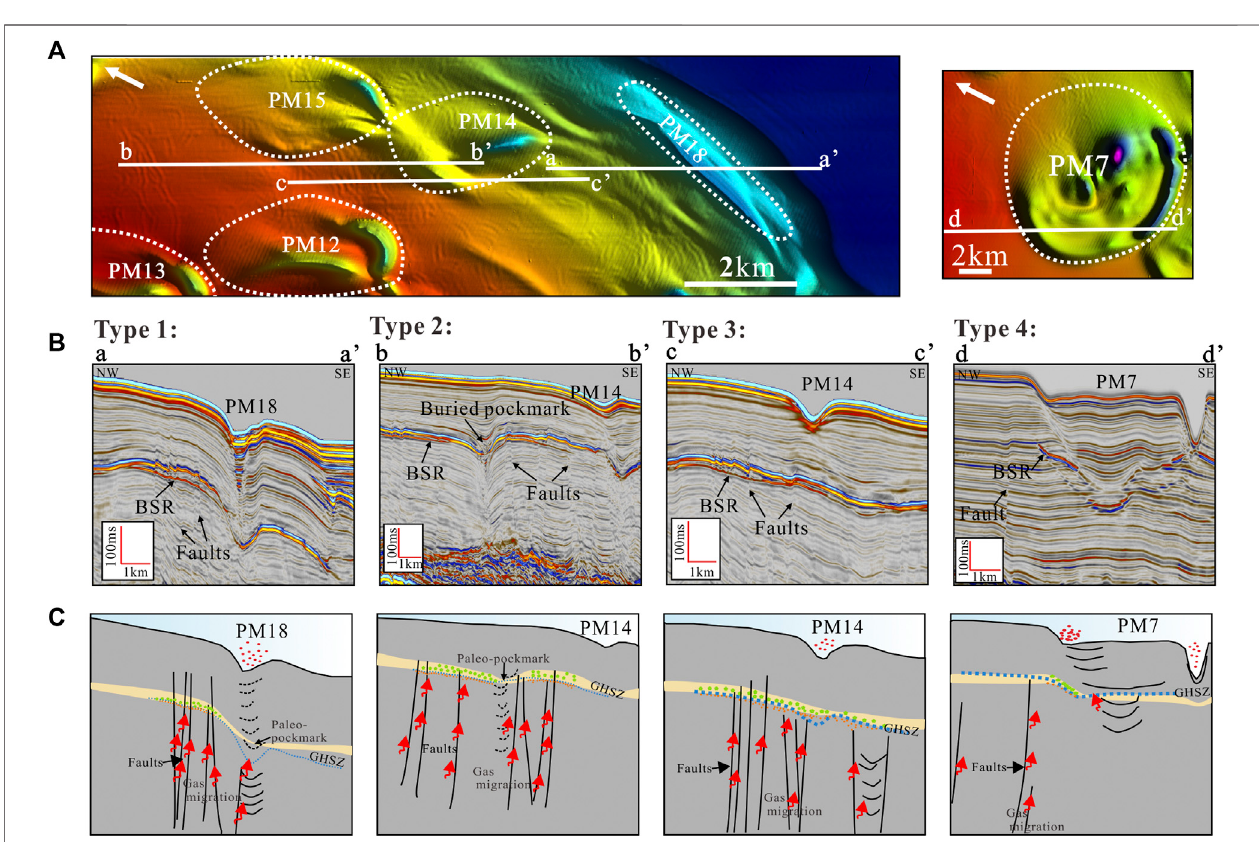
FIGURE7|(A) Detailedmapoftherepresentedpockmarks. (B) – (C) Theseismicsectionsandconceptualviewofthefourtypesofpockmarksinthe3Dstudyarea, showing the relationship between the pockmarks, faults, and gas hydrate.